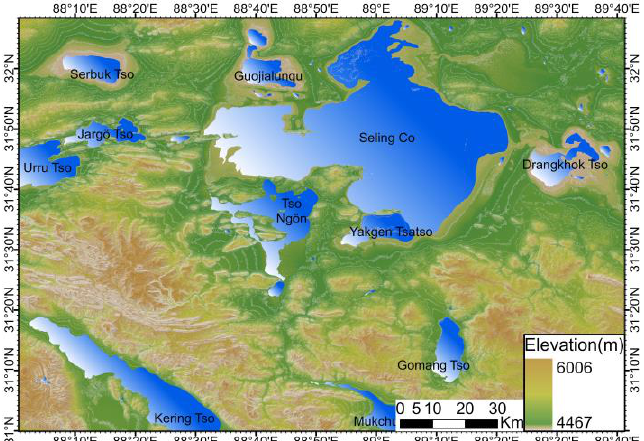
Figure 1. Map of the study